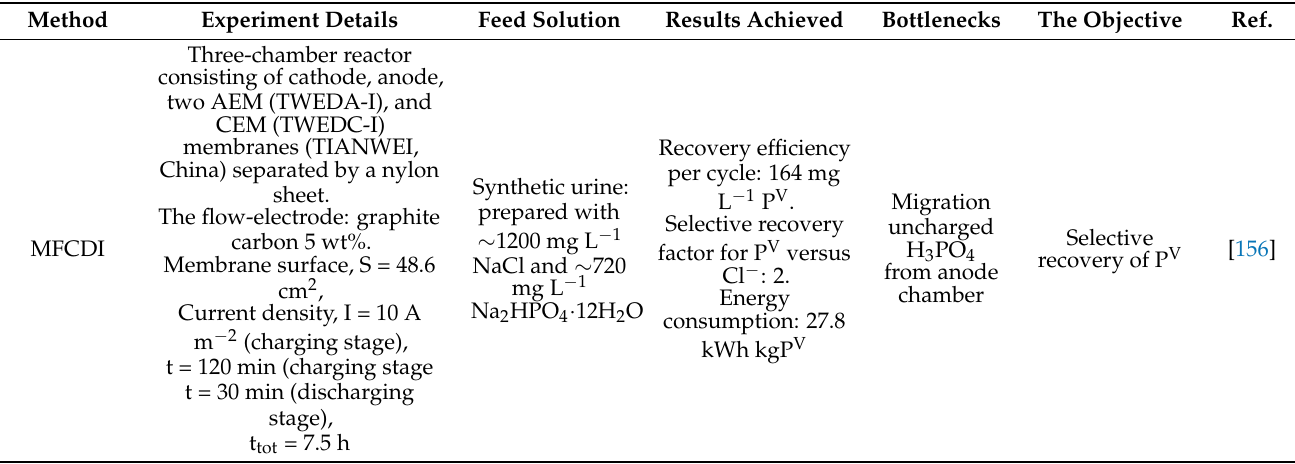
Table 1. Examples of some membrane systems used for nutrient